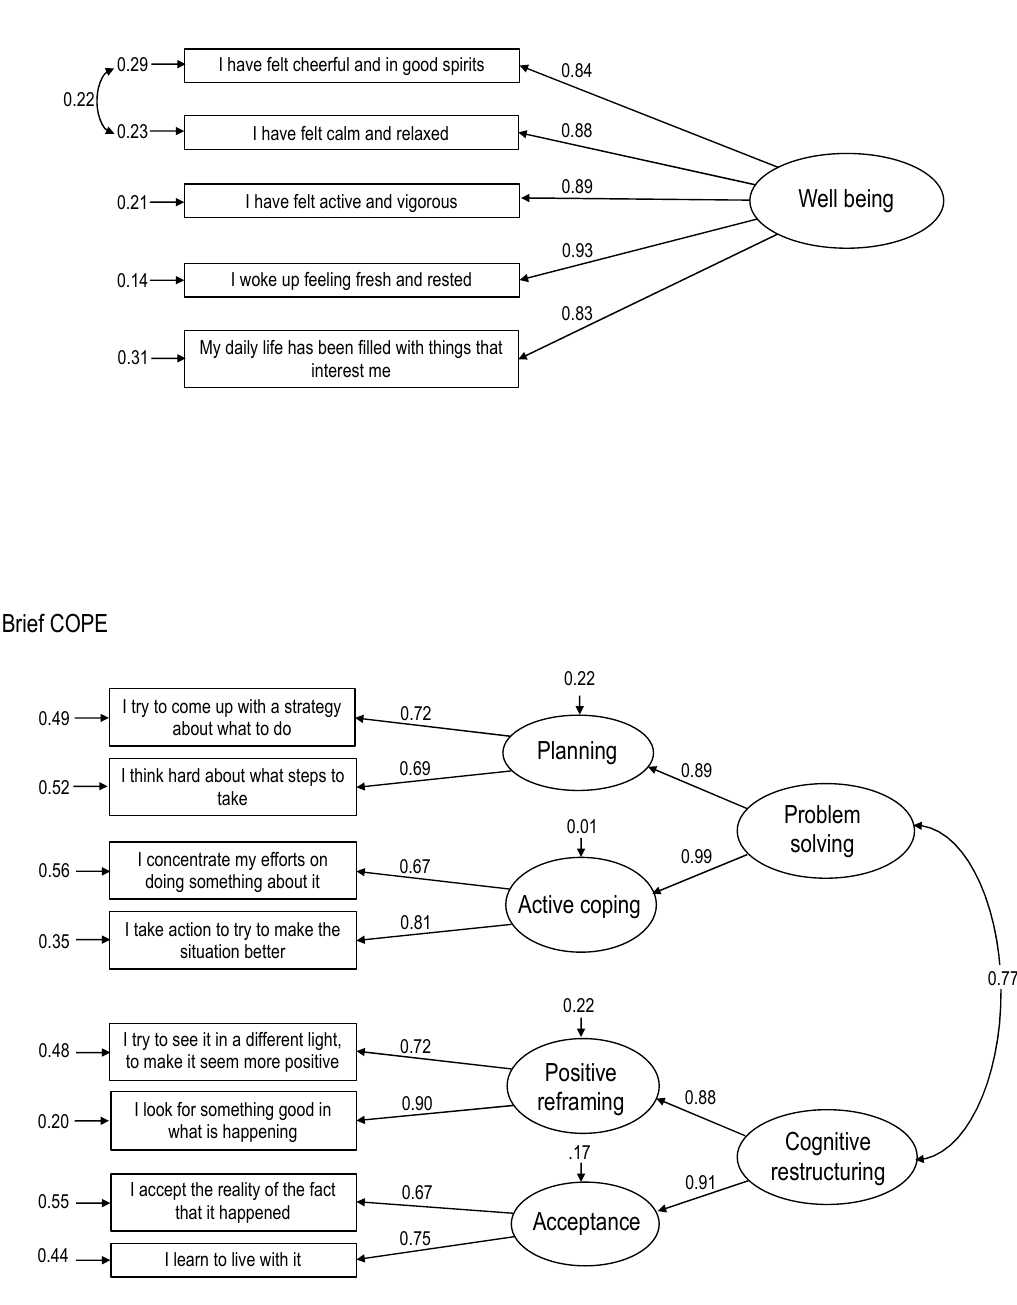
Figure 1. Full structural equation measurement models in the first step of the Structural Equation Model. Panel ( a ) shows the final measurement model for post-migration stressors; panel ( b ) the model for well-being; and panel ( c ) the model for coping. The displayed estimates are standardized coefficients (ß).